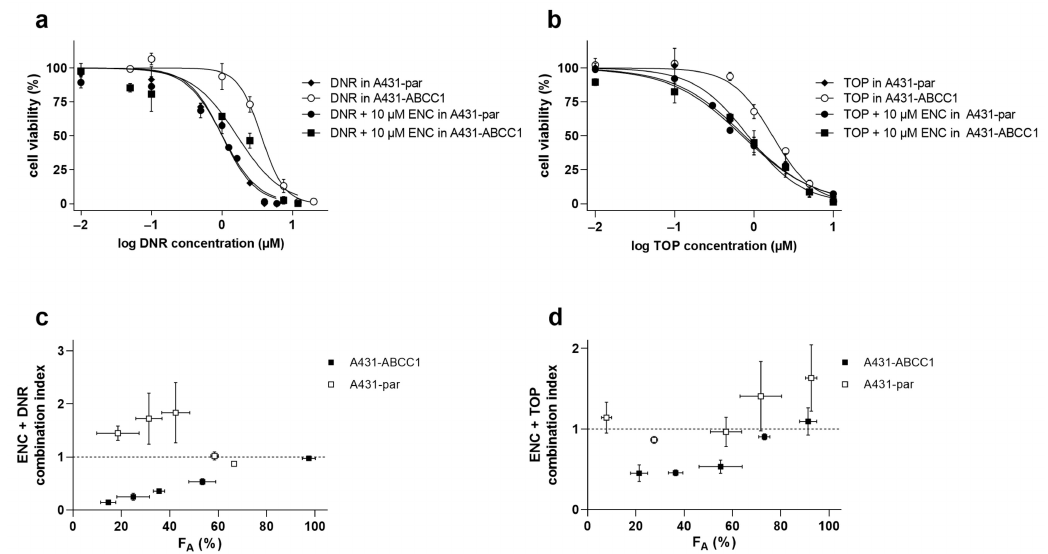
Figure 3. Drug combination effects of 10 µ M encorafenib with ( a ) daunorubicin or ( b ) topotecan in ABCC1-overexpressing A431 and respective parental cells. The cells were treated with the cyto- static agents (daunorubicin/topotecan) alone or in combination with 10 µ M encorafenib for 48 h. MTT assay was subsequently performed for determining the cell viability. Cell proliferative data further proceeded with the CompuSyn 3.0.1 software, where the combination index (CI) values were calculated. Furthermore, F A (fractions of cells affected)-CI plots were drawn for both combination settings ( c , d ). Combination effects were defined according to the CI values as follows: synergistic (CI < 0.9), additive (0.9 < CI < 1.1), or antagonistic (CI > 1.1). At least 3 independent experiments were performed. DNR, daunorubicin; ENC, encorafenib; TOP, topotecan; error bar, standard deviation. Table 1. The analysis of IC 50 shifting for the combination of 10 µ M encorafenib with daunorubicin or topotecan in A431-par and A431-ABCC1 cells. Cell viability data from Figure 3 were used for calculating IC 50 values. Statistics for obtained IC 50 values was conducted by a two-tailed unpaired t -test (** p < 0.01; ns, not significant vs. daunorubicin/topotecan alone group). The reversal ratio (R R ) was calculated for each drug combination in individual cell lines, according to the following